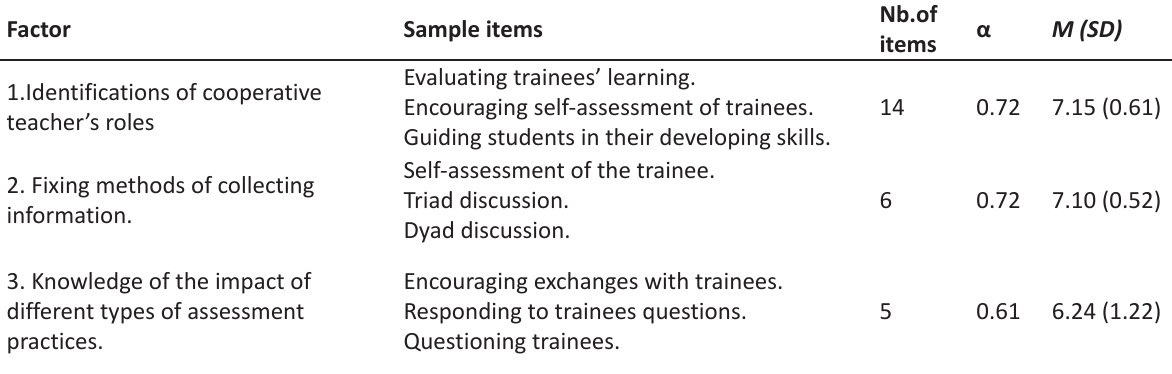
Table 2. Reliability and Descriptive Statistics for the formative assessment practices of cooperative teachers.